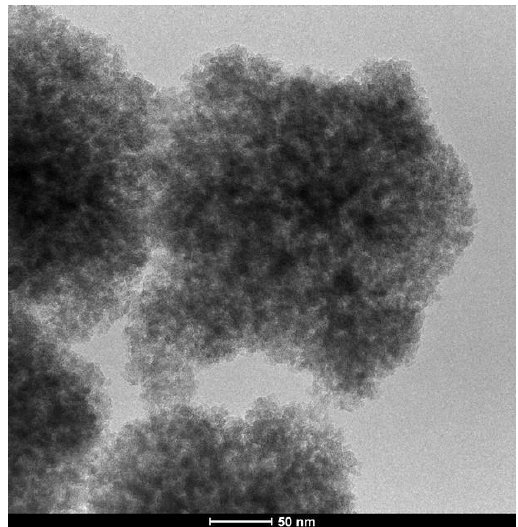
Figure 4. TEM image of TA-MSNPs.